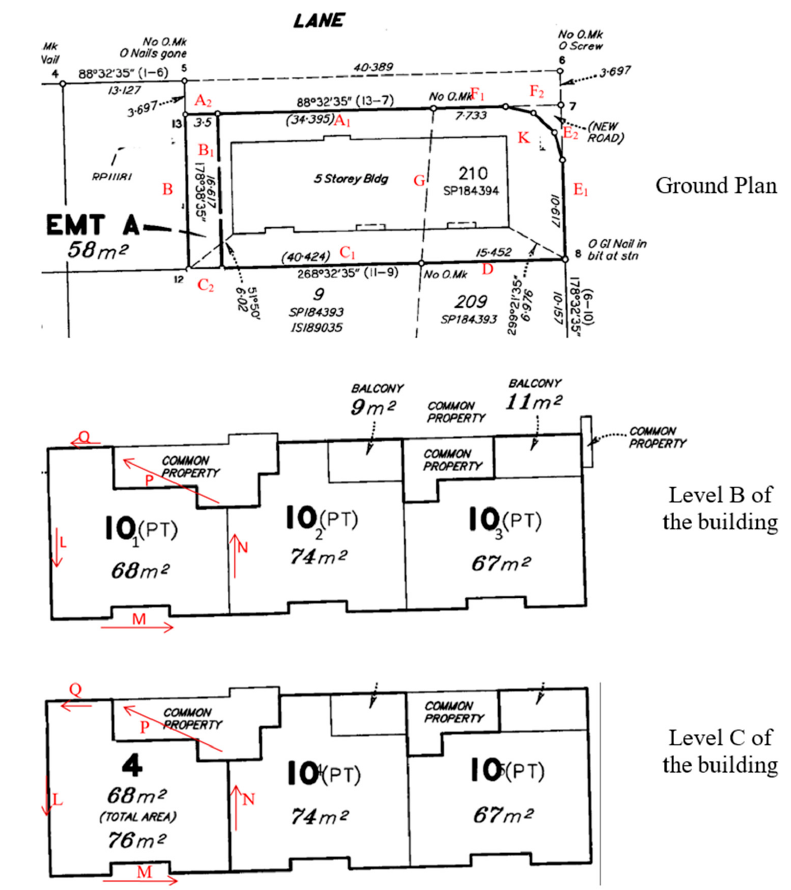
Figure 9. Detail of the building subdivision showing labels used in Table 2. Note that the face string definitions L, M, N, P, and Q are used in the definition of units on multiple floors. Using the labels from Figures 8 and 9, where face strings are shown as capital letters, and faces as lowercase, the following encoding is possible (Tables 2 and 3).